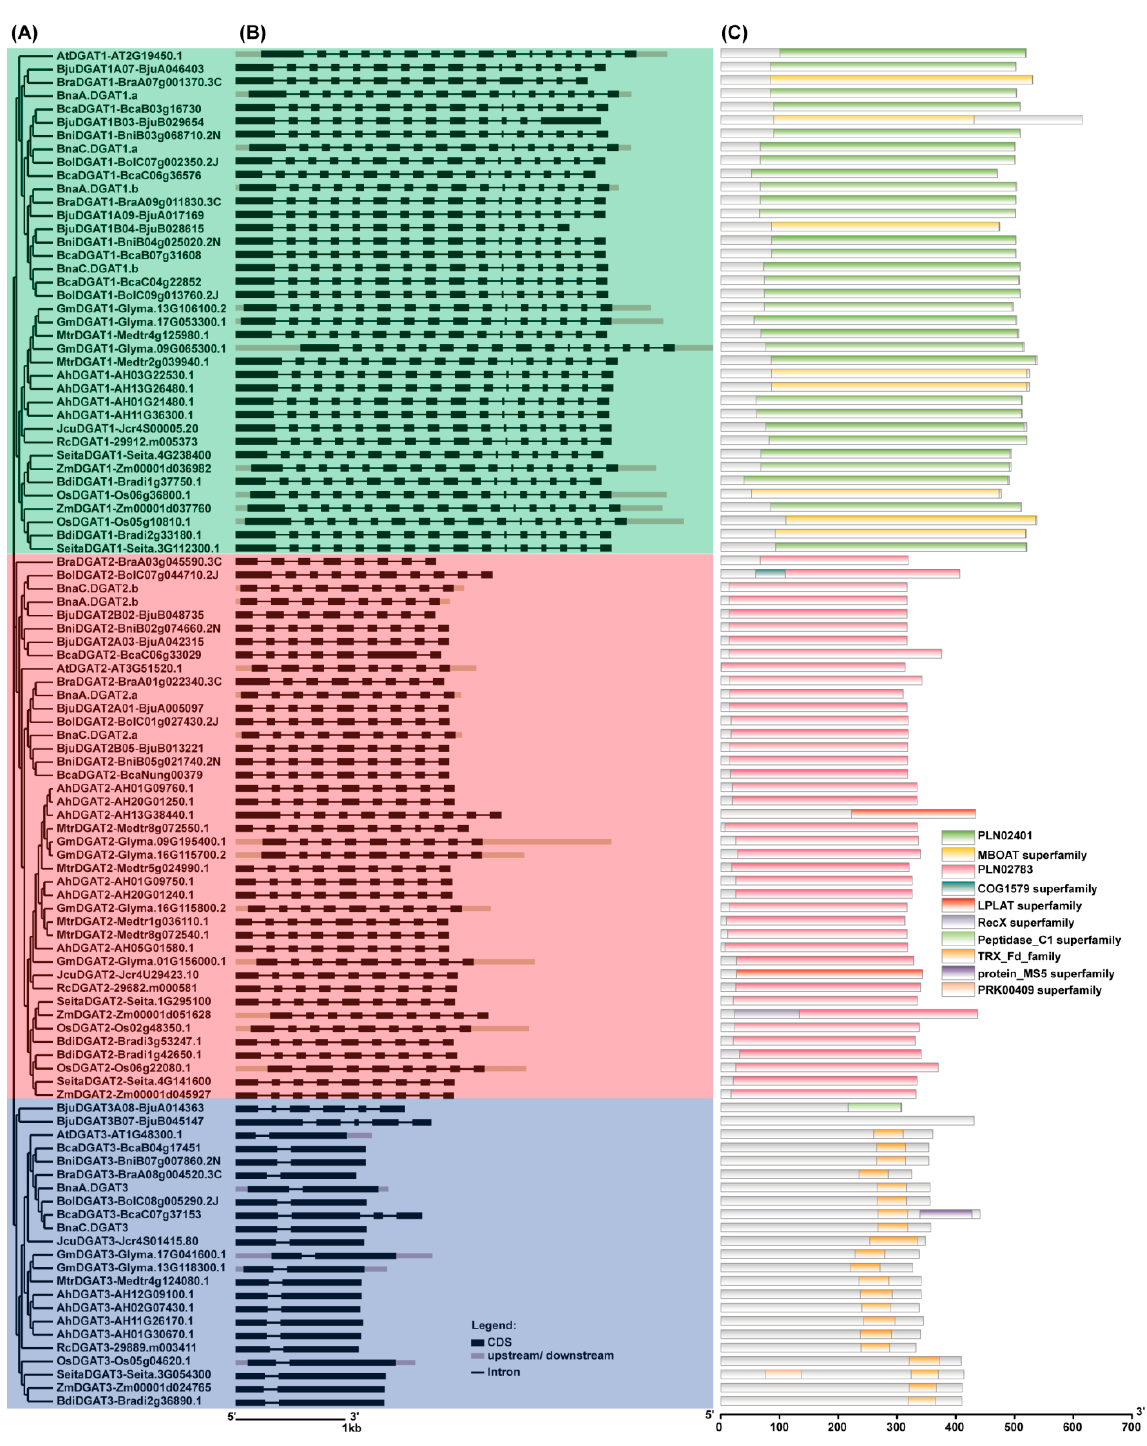
Figure 2. Analyses of phylogenetic tree, gene structures and conserved domains of DGAT family members in Brassica napus and other plant species. ( A ) Phylogenetic tree. DGAT protein sequences were used to construct the phylogenetic tree by MEGA11 software with the neighbor-joining method and 2000 bootstrap replications; ( B ) Gene structures. The genomic DNA and CDSs of DGATs were used to construct the gene structures by the Gene Structure Display Serve (GSDS2.0; http://gsds.gao-lab.org/ (accessed on 20 October 2021)) [56]. Black boxes denote exons within cod- ing regions, and the lines connecting exons represent introns. Grey boxes indicate the upstream or downstream regions of the CDS of DGAT genes. The length of the boxes represents the size of the corresponding exons; ( C ) Conserved domains. A functional search of the conserved domains was performed using the Conserved Domain Database (CDD) with Batch CD-Search in NCBI.